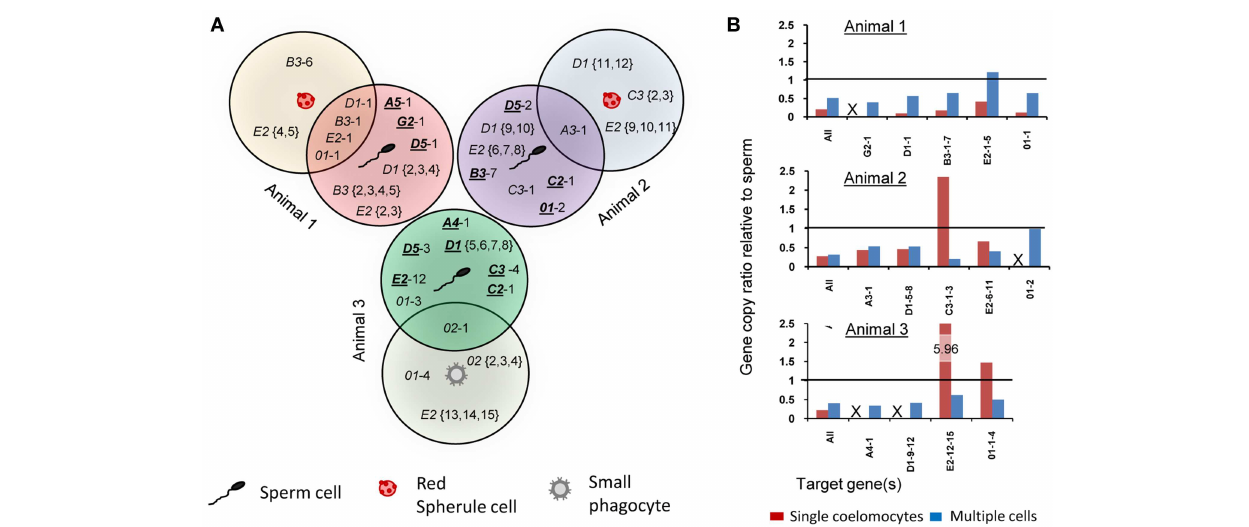
FIGURE 7 | Single cell analysis indicates somatic gene deletion, duplication, and sequence diversification in the SpTrf gene family. Amplicons of one coelomocyte and one sperm from each animal (as indicated in Figure 5B ) were cloned and sequenced. (A) The Venn diagram illustrates shared and unique gene amplicons (element pattern followed by a sequence variant number after the dash) from single coelomocytes and single sperm from three animals. Underlined element patterns indicate gene sequences that are unique to sperm and are not found in coelomocytes for each animal. (B) qPCR results using primers that amplify the second exon of all SpTrf genes plus primers designed for specific gene sequences are shown as ratios of coelomocyte amplicons relative to sperm amplicons for each animal. Ratios of gene copy number between multiple coelomocyte and multiple sperm samples that were not processed for WGA are indicated in blue. Ratios of gene copy number between single coelomocyte and single sperm from the same animal (same cells as in A ) are shown in red. The horizontal line represents a ratio of 1 (identical gene copy numbers between coelomocyte and sperm). Samples in which primers did not generate amplicons by qPCR are indicated with an X. See Table S2 for details.